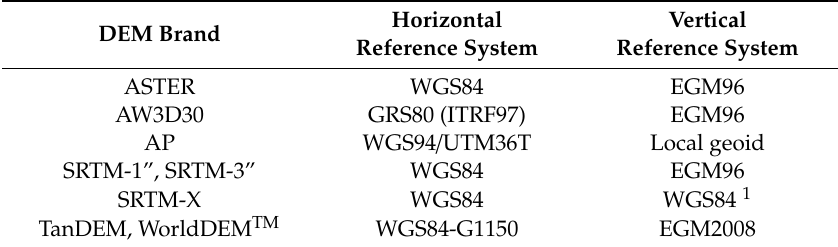
Table 2. Reference systems used in the investigated digital elevation models